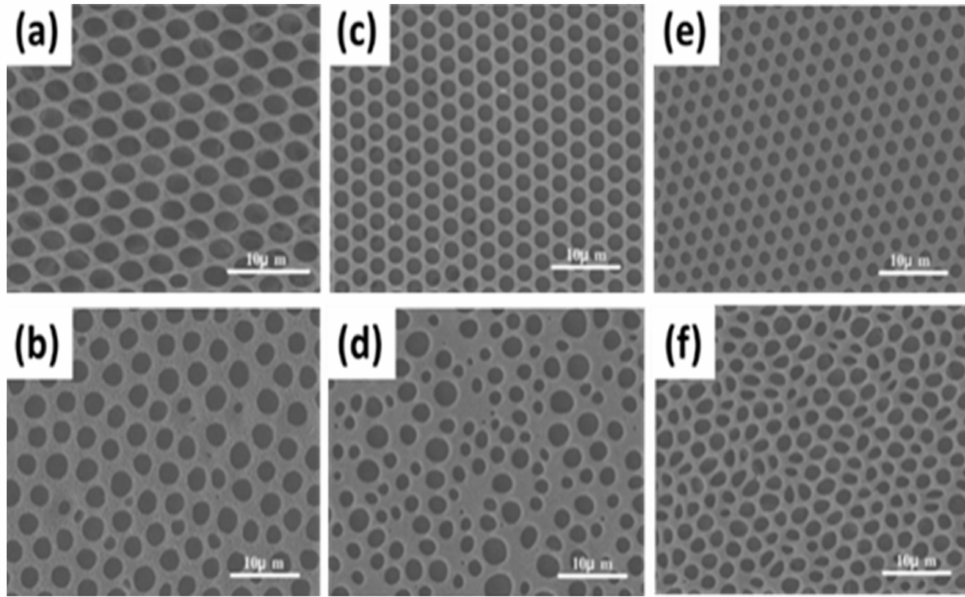
Figure 15. SEM images of porous PACA films fabricated from monomer solutions of ( a ) ECA, ( c ) BCA, ( e ) OCA, and polymer solutions of ( b ) PECA, ( d ) PBCA, ( f ) POCA. Reprinted with permission from ref. [106]. Copyright 2010 Journal of Colloid and Interface